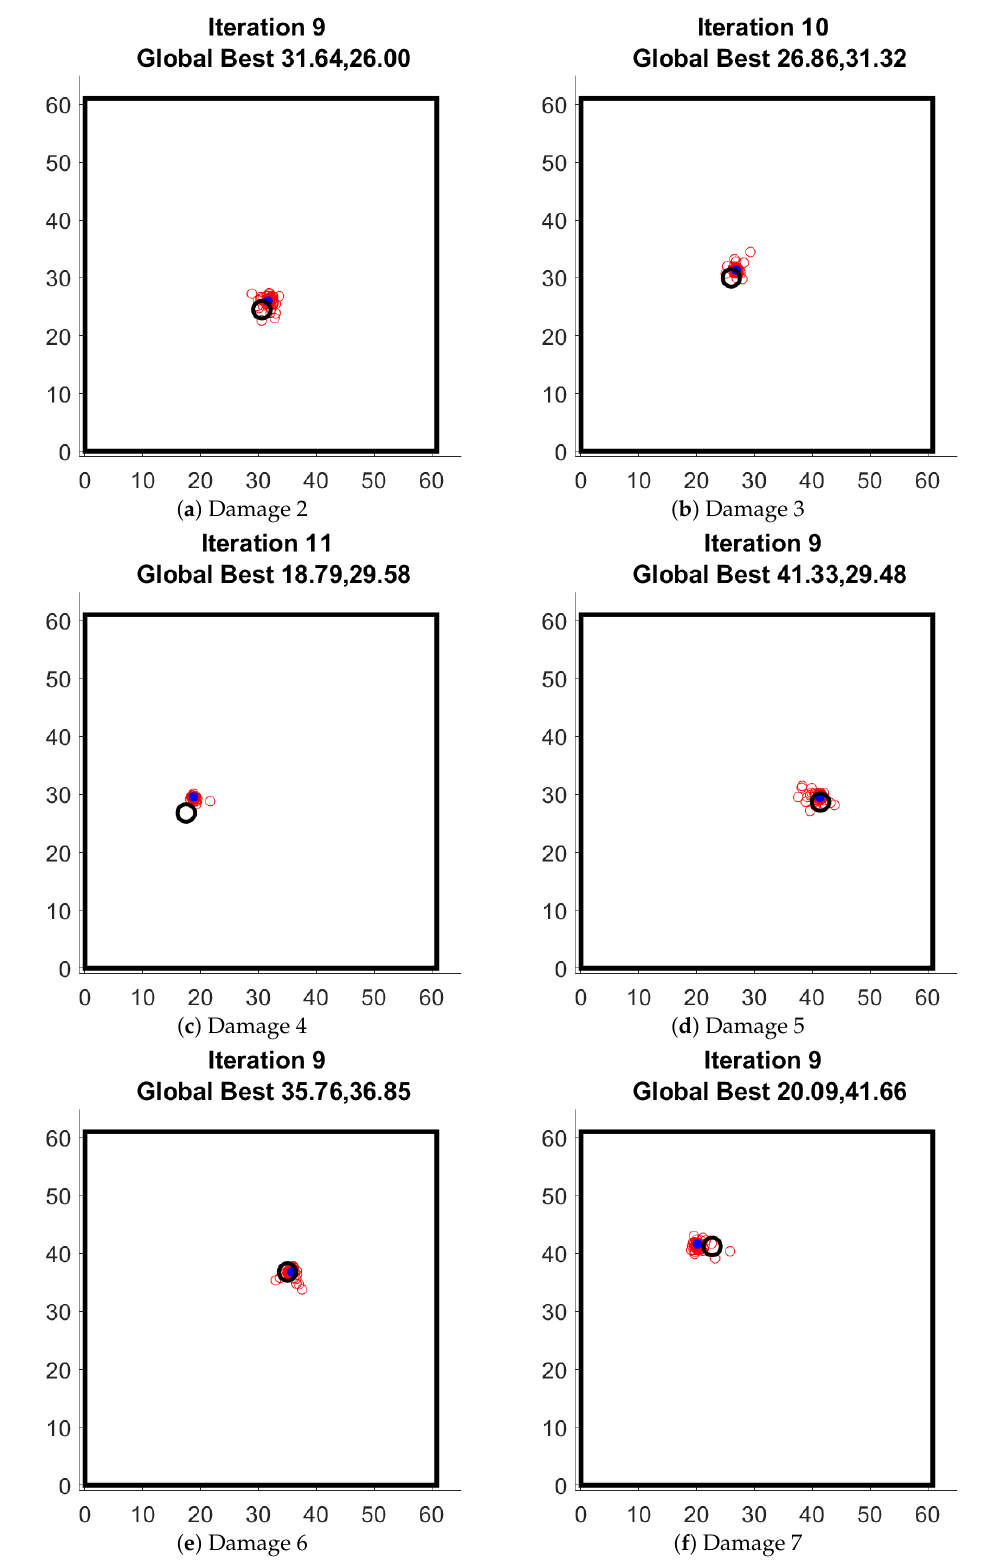
Figure 7. Damage localization for 6 damage scenarios. (black circle shows the real location of